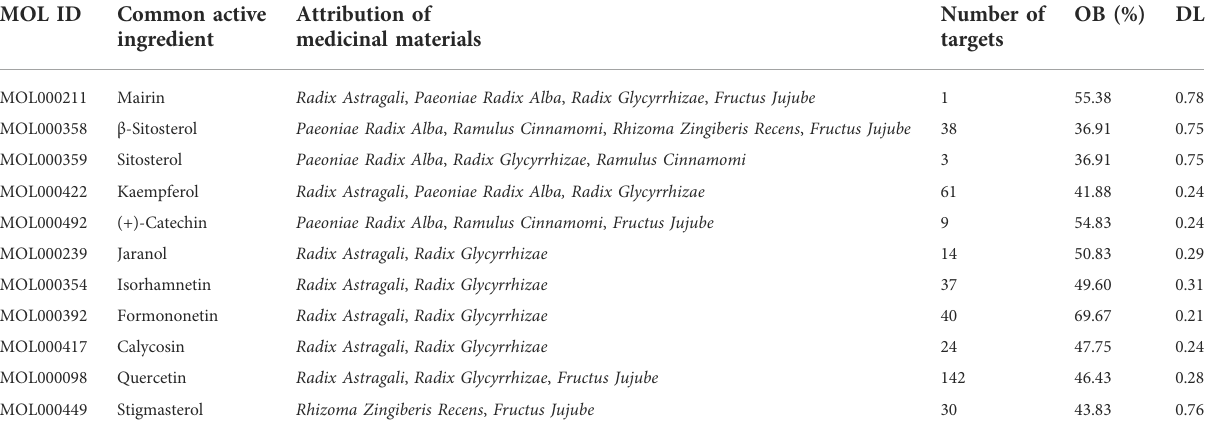
TABLE 1 Information on common active ingredients of Huangqi Jianzhong decoction. MOL